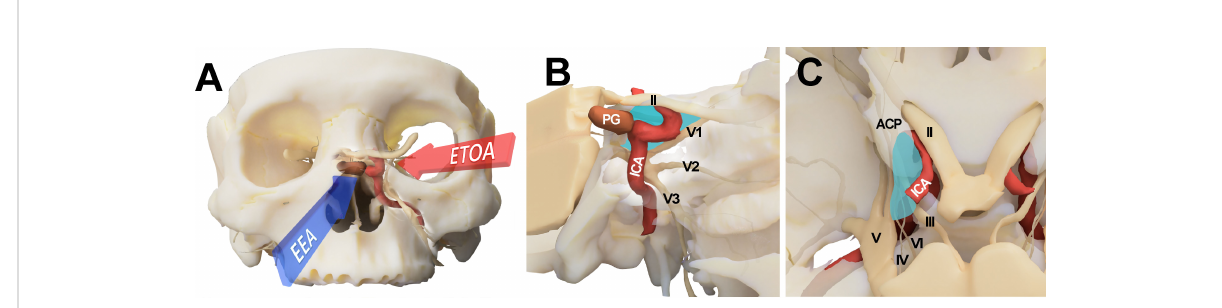
FIGURE 1 Conceptual illustration for endoscopic transorbital approach (ETOA) and endoscopic endonasal approach (EEA) to the cavernous sinus. (A) The cavernous sinus was approached from the infero-medial side under EEA whereas ETOA accesses cavernous sinus from the superolateral side. (B, C) Consequently, the lateral compartment of cavernous sinus (blue shadow) was more directly accessed under ETOA while its access was hindered by the tortuous course of internal carotid artery under EEA. ACP, anterior clinoid process; ICA, internal carotid artery; II, optic nerve; III, oculomotor nerve; IV, trochlear nerve; PG, pituitary gland; V, trigeminal nerve; V1, ophthalmic branch of trigeminal nerve; V2, maxillary branch of trigeminal nerve; V3, mandibular branch of trigeminal nerve; VI, abducens